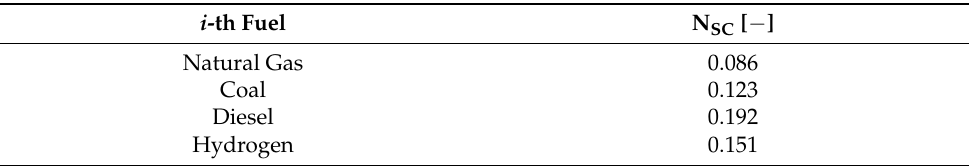
Table 2. Results for the EGN concerning the combustion